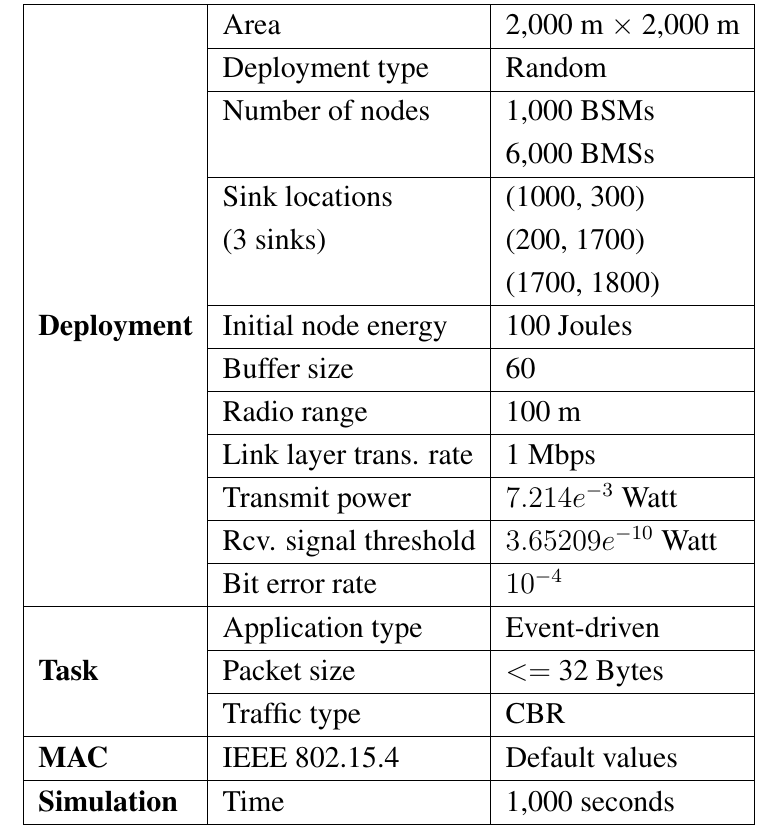
Table 1. Configuration of Parameters.